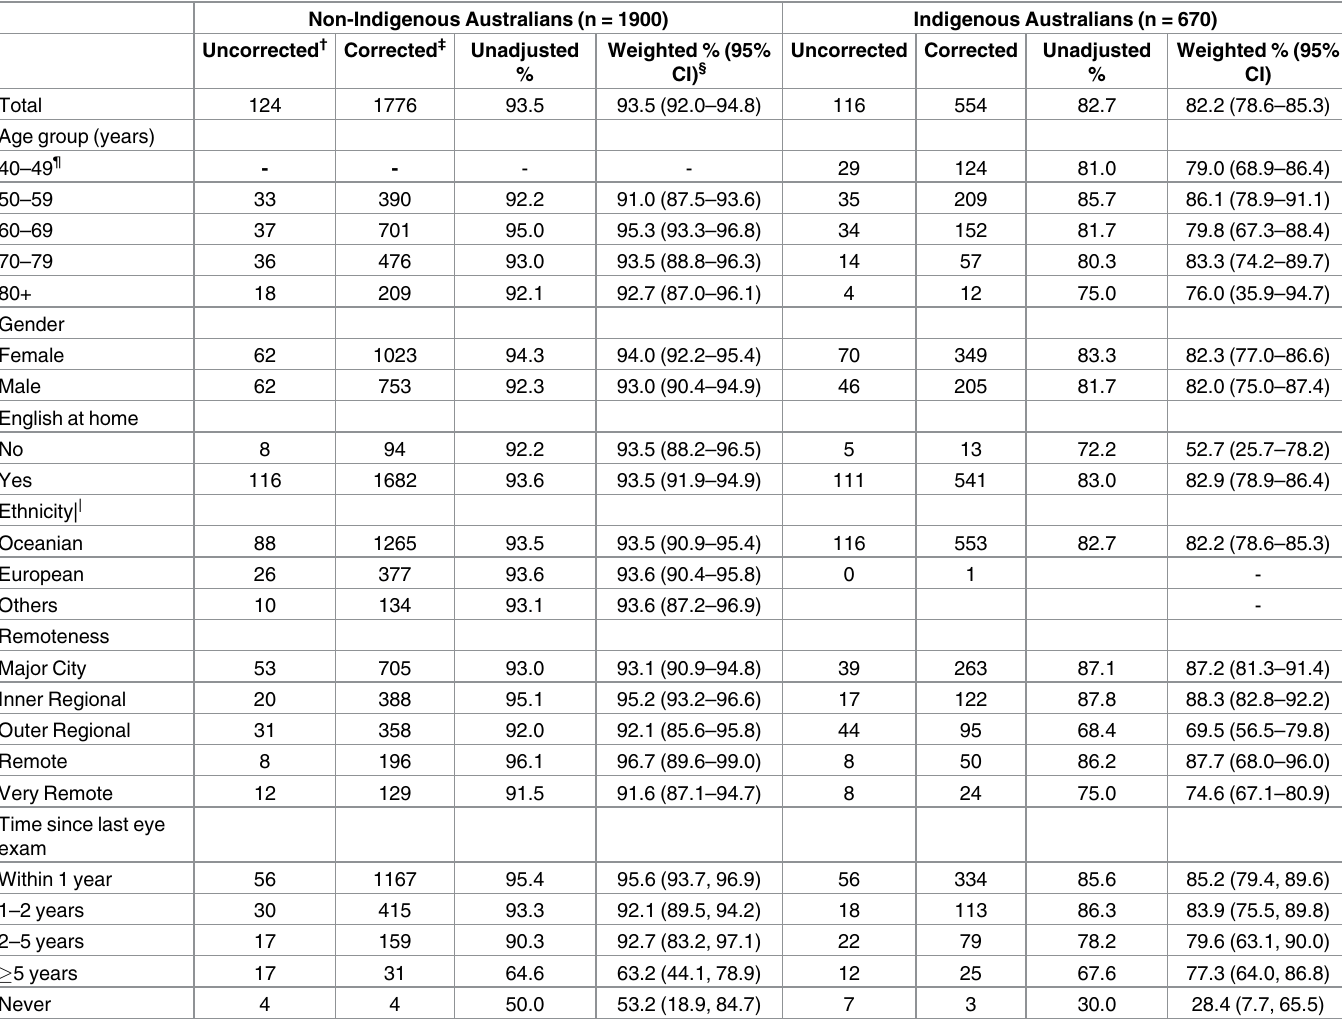
Table 2. Refractiveerror treatment